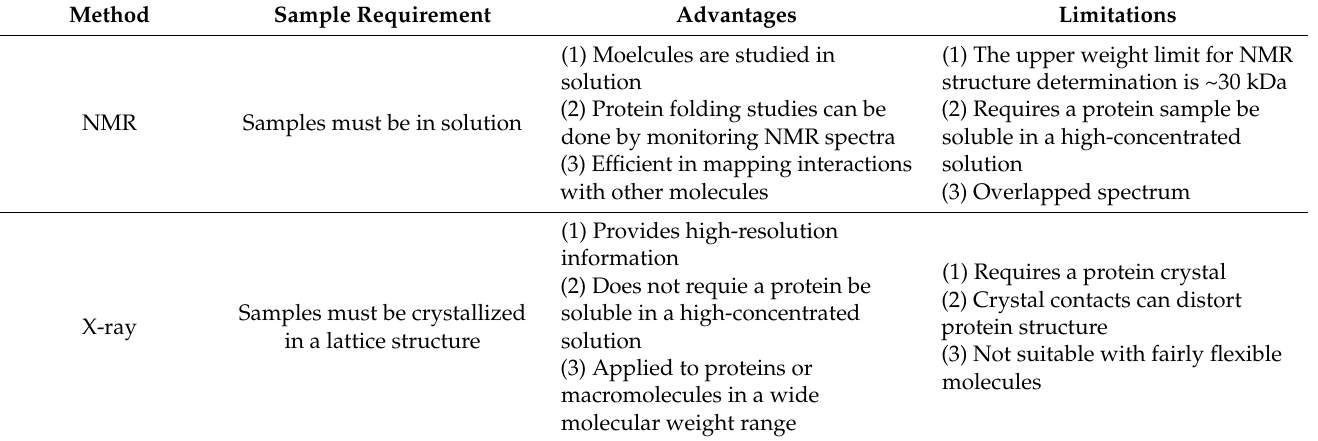
Table 1. Summary of three commonly used structural determination